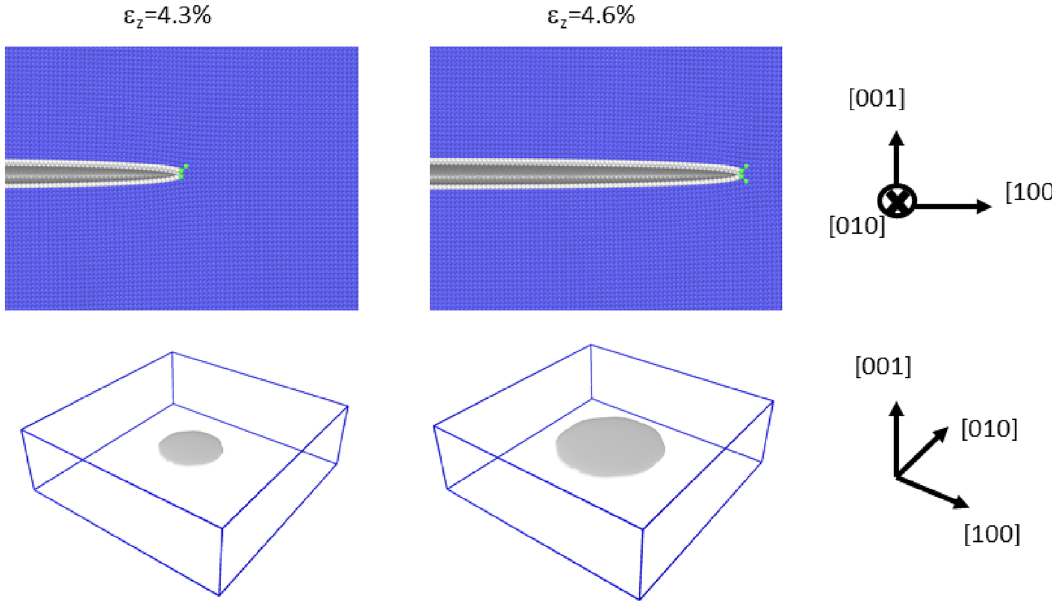
Figure 3. The initial condition of the {100} cleavage simulation and the snapshot after imposing 0.3% mode-I tensile strain. The upper diagrams show the cross sections in the vicinity of the crack front. The common neighbor analysis was used for determining the atomic color. The bottom diagrams show the cracked surfaces in